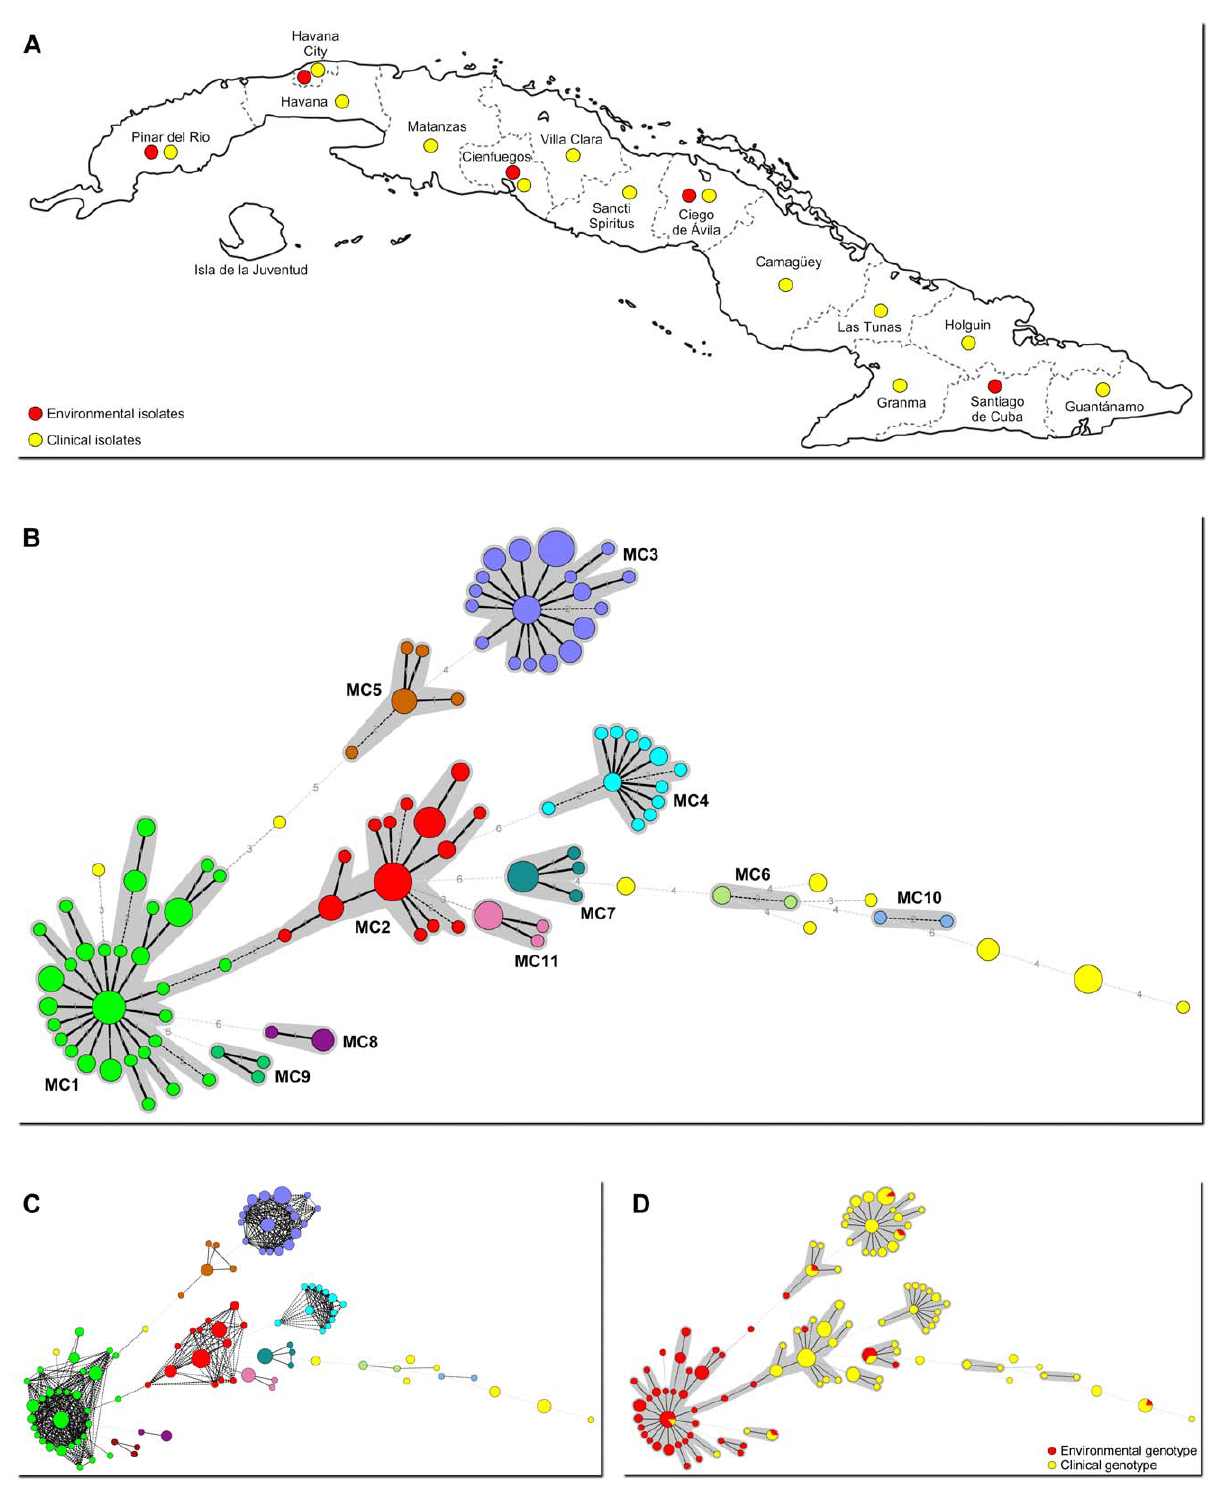
Figure 1. Origin of samples and relationships between genotypes. A: Map of Cuba. Colored dots indicate provinces from which clinical and/ or environmental samples were available. B: Minimum spanning tree (MST) based on a multistate categorical analysis representing the genotypes of 190 C. neoformans var. grubii isolates from Cuba. Each circle represents a unique genotype. The size of the circle corresponds to the number of isolates with that genotype. Genotypes are linked to their closest relative. Numbers and connecting lines correspond to the number of different markers between genotypes. Genotypes with identical colors and connected by a shaded background are part of a microsatellite complex (MC). In yellow are unique genotypes that are not part of a MC. C: Same as B, but now showing cross-links between all genotypes that differ in no more than 2 markers. D: Same MST as in B, but now showing genotypes obtained from clinical and environmental samples.